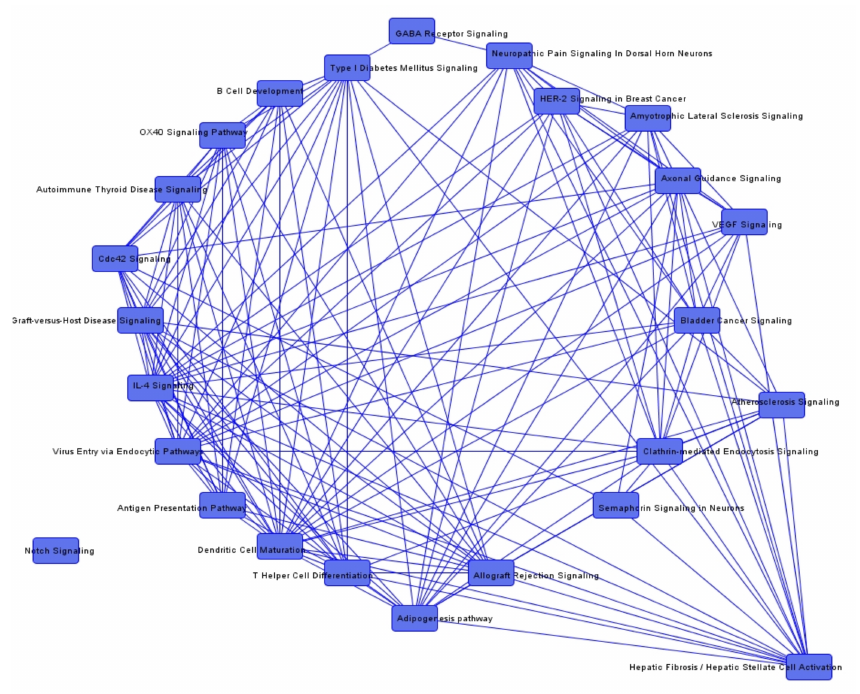
Figure 2. Overlapping canonical pathways in irradiated recurrent vs. non-irradiated sporadic vestibular schwannomas